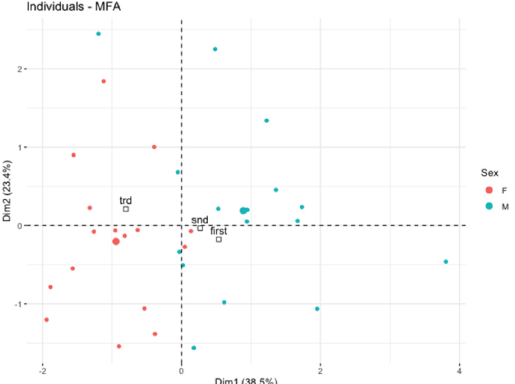
Figure 5. Individual factor map showing gender-based data distribution. F—Female individuals colored in red, M—Male individuals colored in blue.